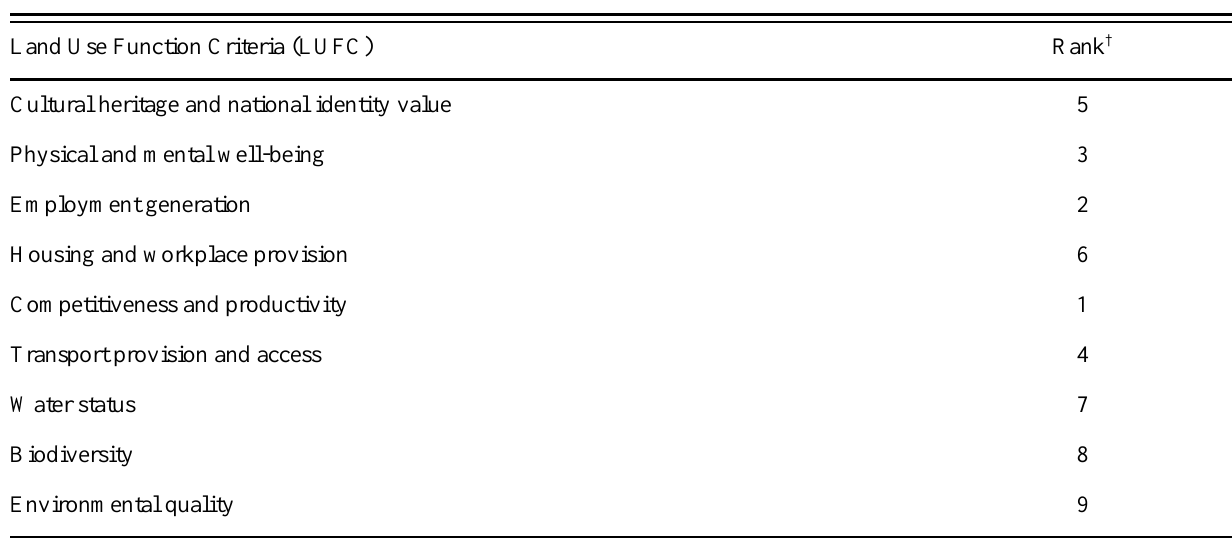
Table 7 . Results of LUFC ranking in Malta Land Use Function Criteria (LUFC) Rank † Cultural heritage and national identity value 5 Physical and mental well-being 3 Employment generation 2 Housing and workplace provision 6 Competitiveness and productivity 1 Transport provision and access Water